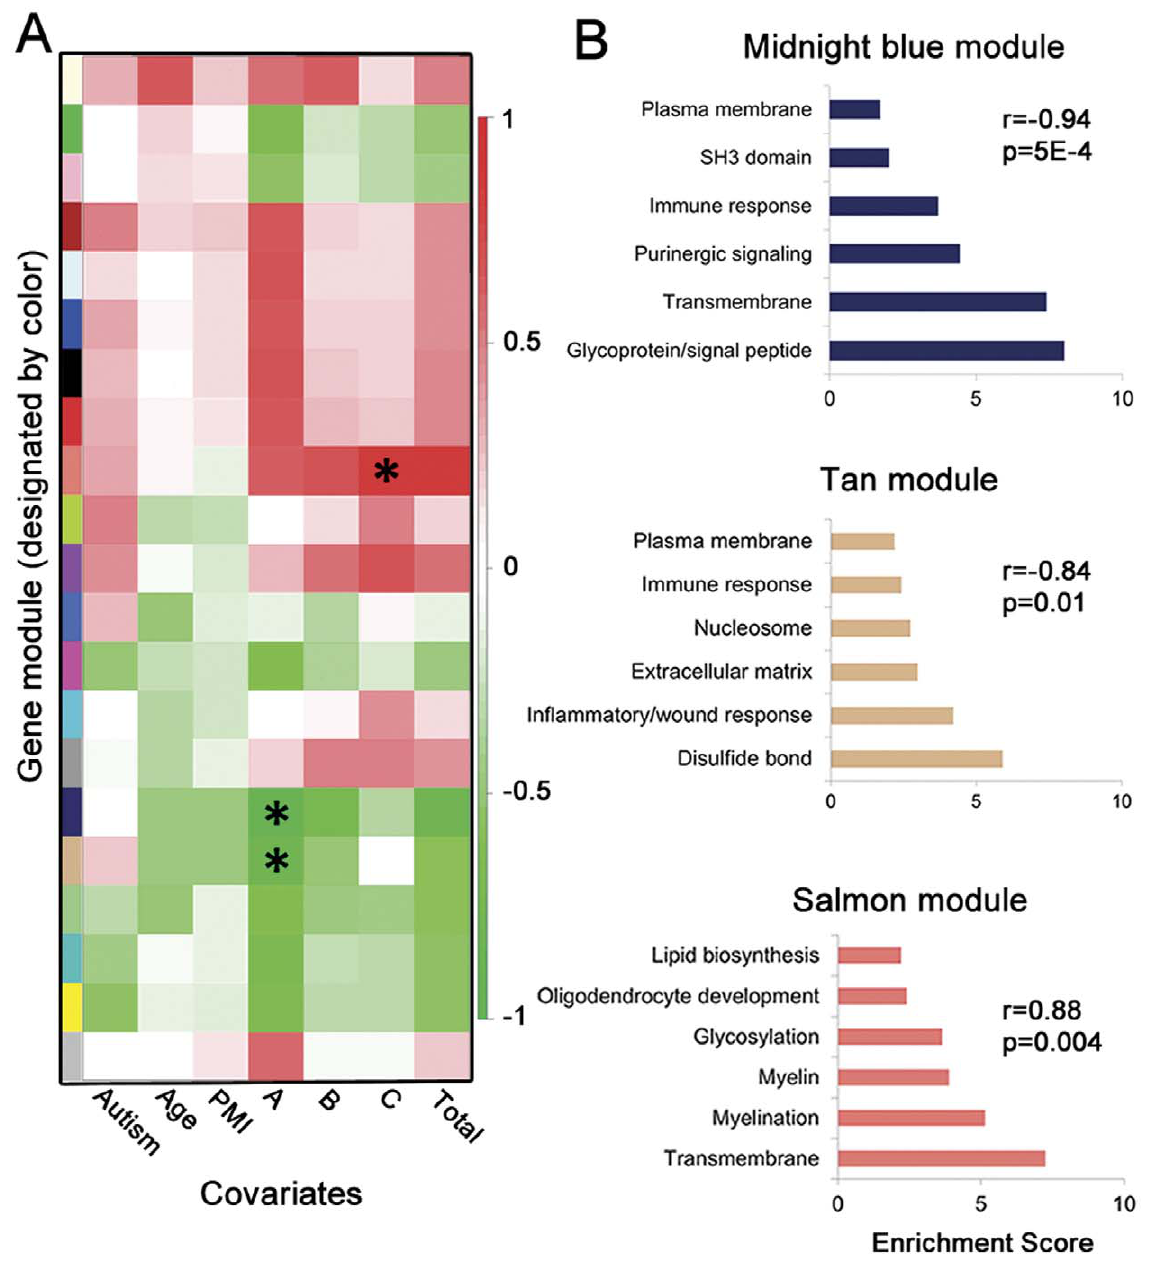
Figure 2. Specific domains of the Autism Diagnostic Interview-Revised (ADI-R) are associated with specific gene modules. ( A ) Heatmap of module-variable associations for cerebellar hemisphere samples from weighted genome co-expression network analysis, including domain scores for the ADI-R. Cells are color-coded by correlation coefficient and * is placed in cells having associations with p-values # 0.01. Autism, dichotomous variable autism vs control; PMI, postmortem interval; A, ADI-R Social interaction impairments domain; B, ADI-R Communication and language impairments domain; C, ADI-R Repetitive and stereotyped behaviors domain. ( B ) Gene ontology enrichment annotation clusters for the three significant gene modules associated with specific ADI-R domain scores. P, p-value; r, Pearson correlation